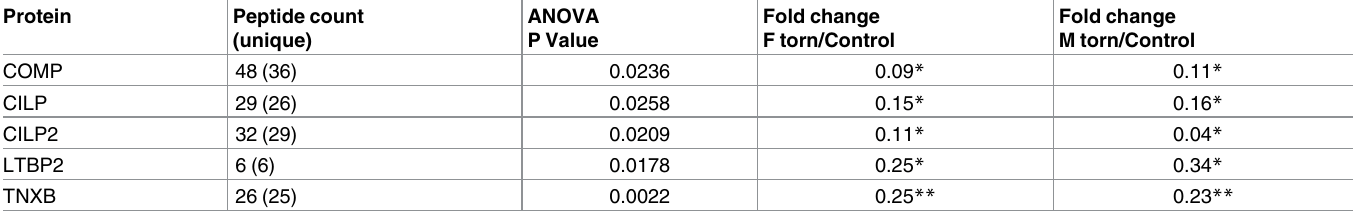
Table 5. The mean relative abundance of differentially expressedextracellular proteins in the elastasedigested samples, mean (SEM), ( * P < 0.05 ** P < 0.01significantly different from control). Protein Peptide count (unique)